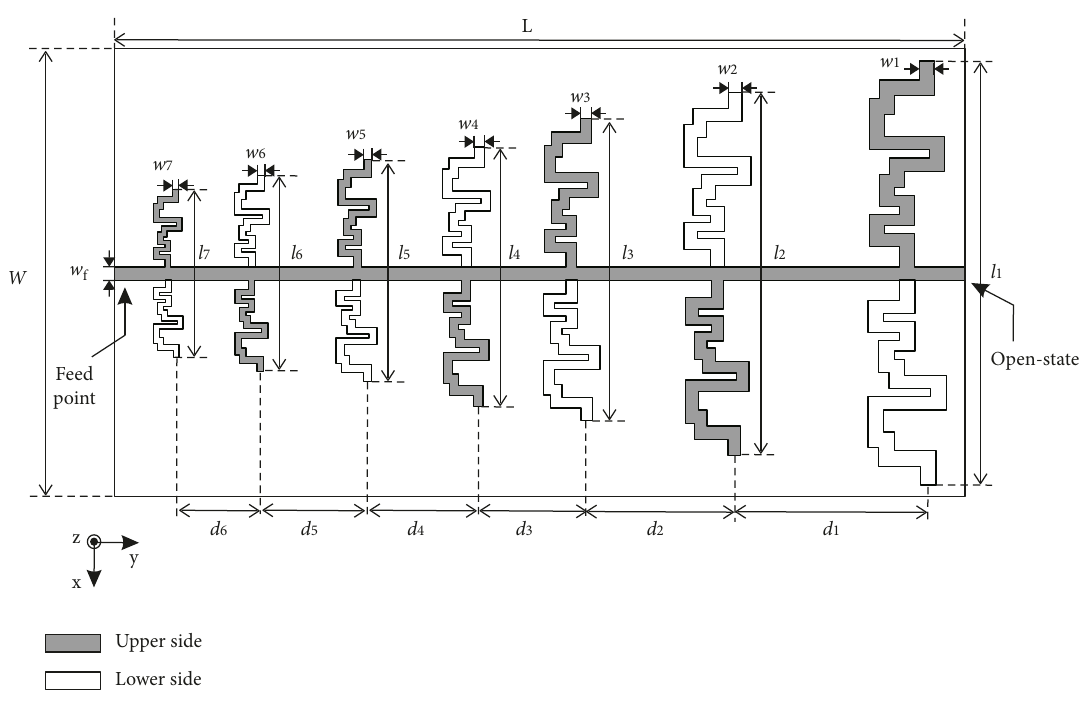
Figure 2: Geometry of the log-periodic meandered dipole array (LPMDA) antenna.